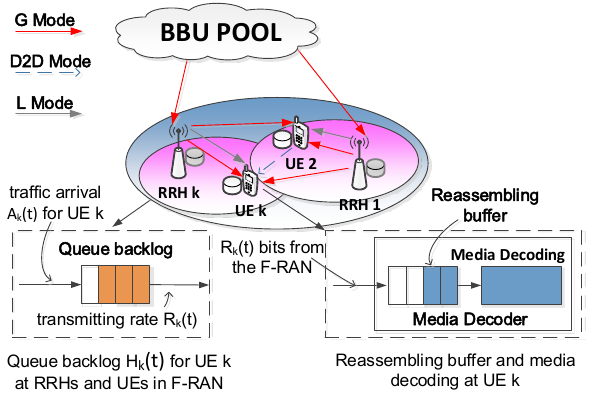
Fig. 3. An illustration of queues’ dynamics in F-RAN, including two parts as illustrated in the picture. Once the total number of parity bits for current segment at the reassembling buffer is equal to the length of one segment, the whole segment is decoded at the media decoder and the reassembling buffer is cleared so that the media decoder can read the next segment from the playback